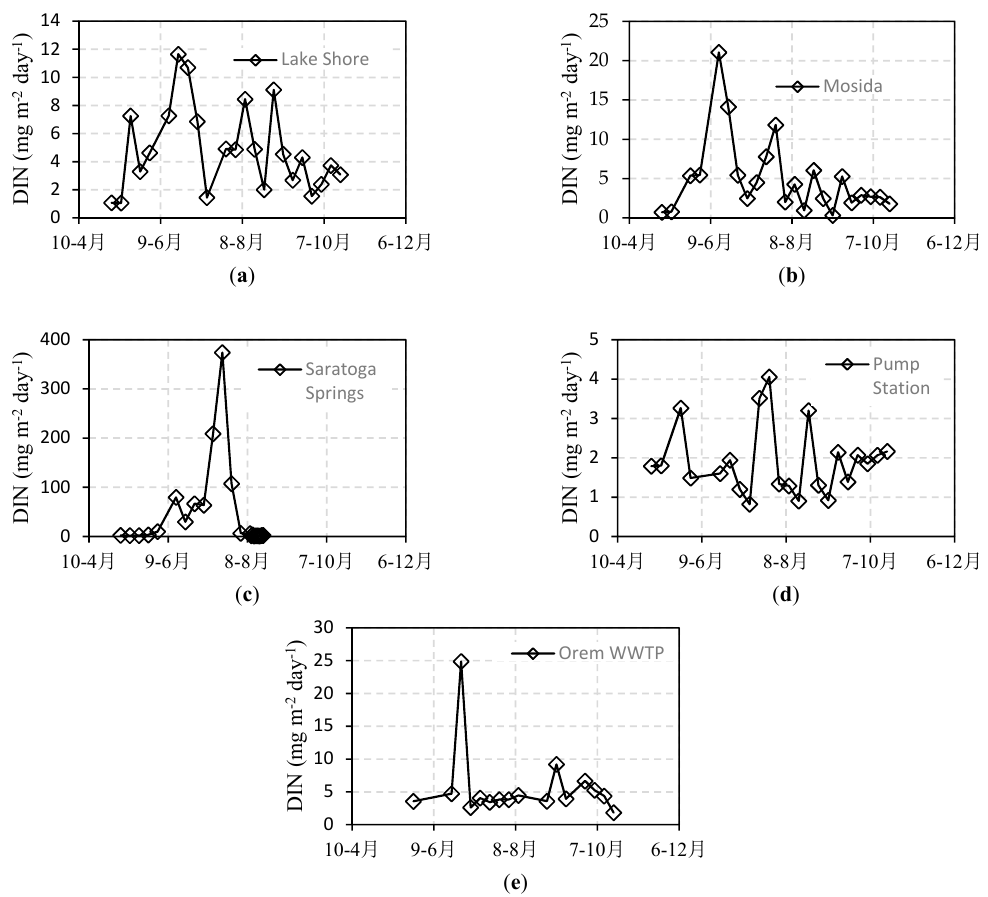
Figure 5. Temporal variations in DIN by sample locations: ( a ) Lake Shore; ( b ) Mosida; ( c ) Saratoga Springs; ( d ) Pump Station; ( e ) Orem WWTP.